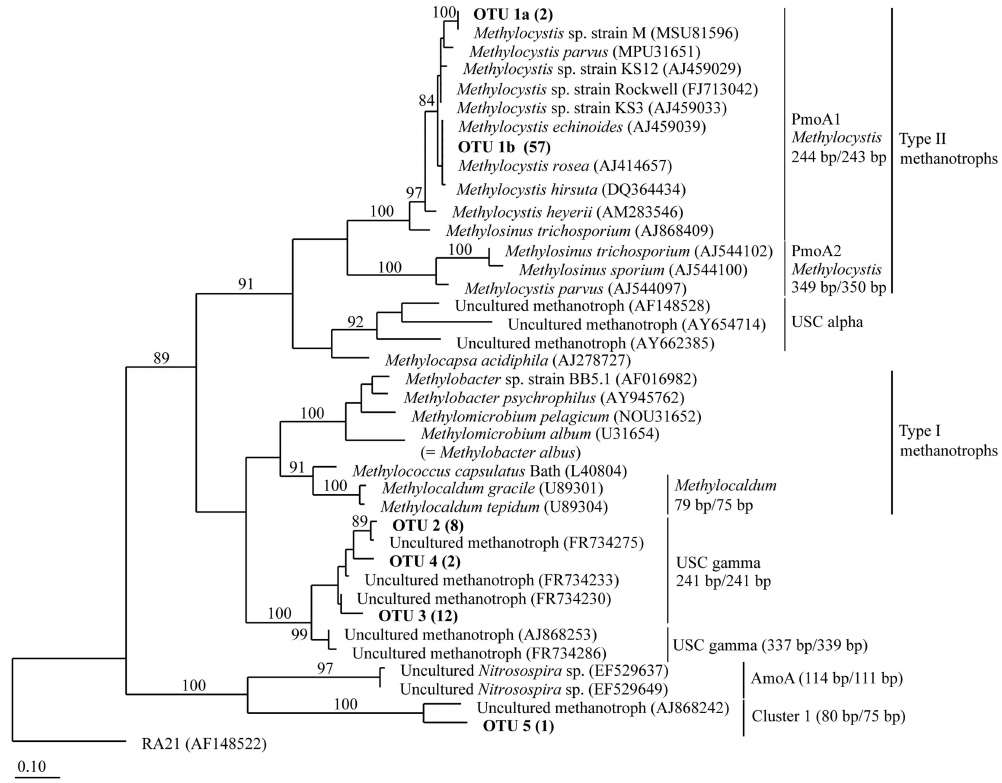
Fig. 3. Maximum likelihood tree showing the phylogenetic affiliation of pmoA sequences obtained from different glacier forefields. The pmoA tree was constructed based on 139 derived amino acid sequence positions. The neighbor-joining method resulted in essentially the same tree topology. Sequences obtained in the course of this study were grouped into 5 species-level units (OTU 1 to 5) based on an amino acid sequence identity threshold of 93%. The number of clones obtained for each OTU is given in parentheses. All species-level OTUs also contain published pmoA sequences. Predicted T-RF lengths based on MspI are shown on the left side, while the experimental T-RF lengths are indicated on the right side. The in silico predicted T-RF lengths were experimentally confirmed by T-RFLP analysis of individual pmoA clone sequences. Bootstrap values greater than 80 are shown (100 replicates). The sequence of RA21 (AF148522) was used as outgroup. The scale bar represents 10% sequence divergence or 0.1 substitutions per amino acid